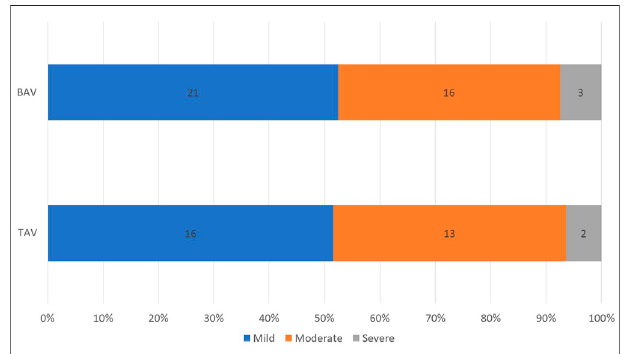
FIGURE 1 | Distribution of AS severity by groups.